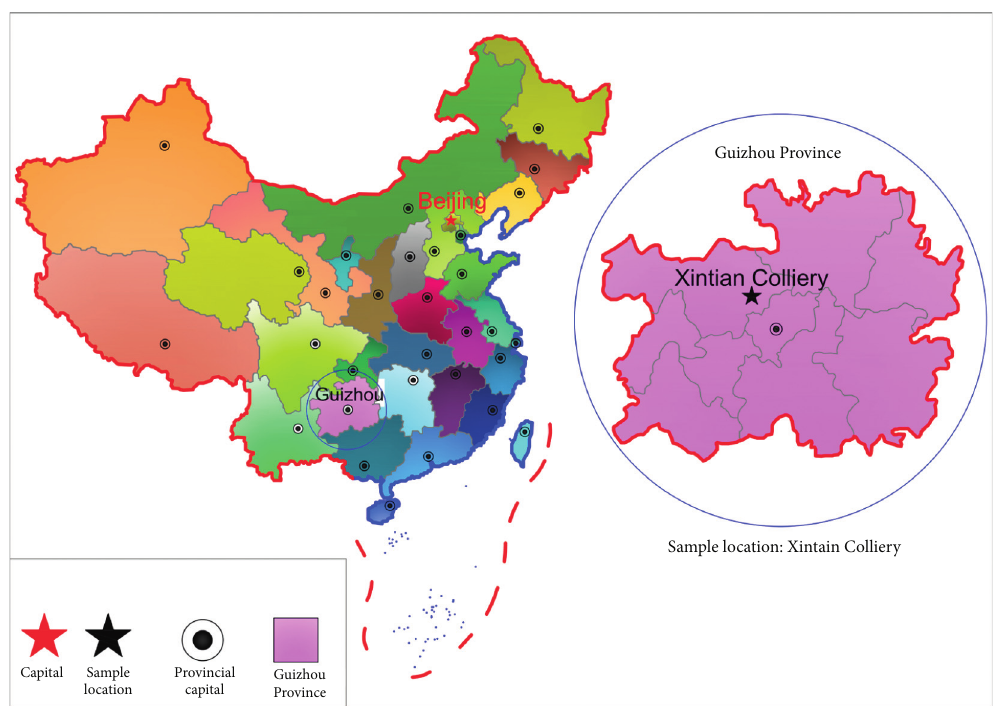
Figure 2: Geographical location of the coal